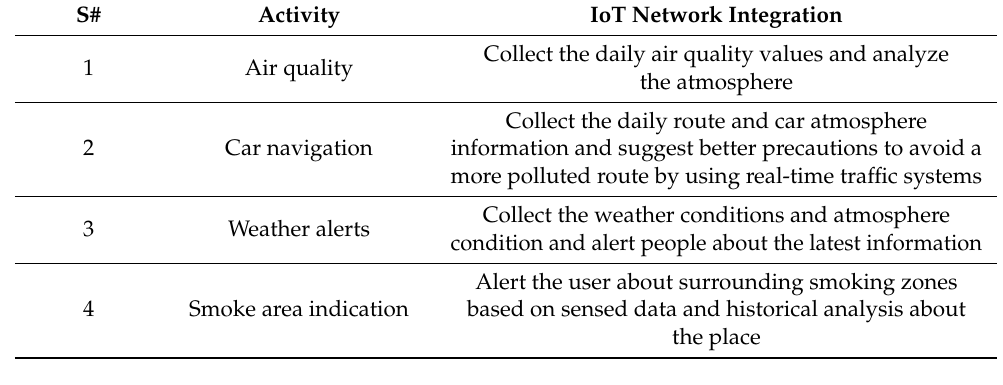
Table 1. Self-organizing activities and IoT.